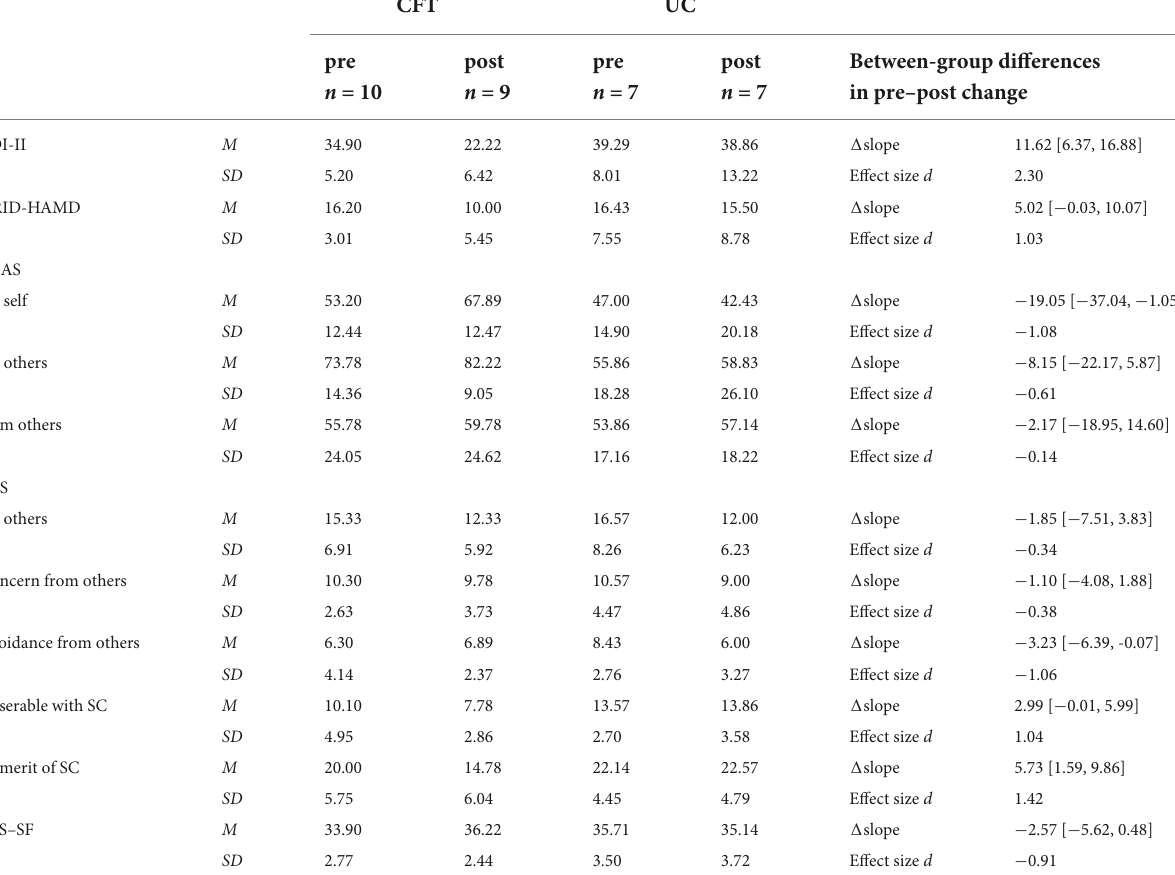
TABLE 3 Changes in